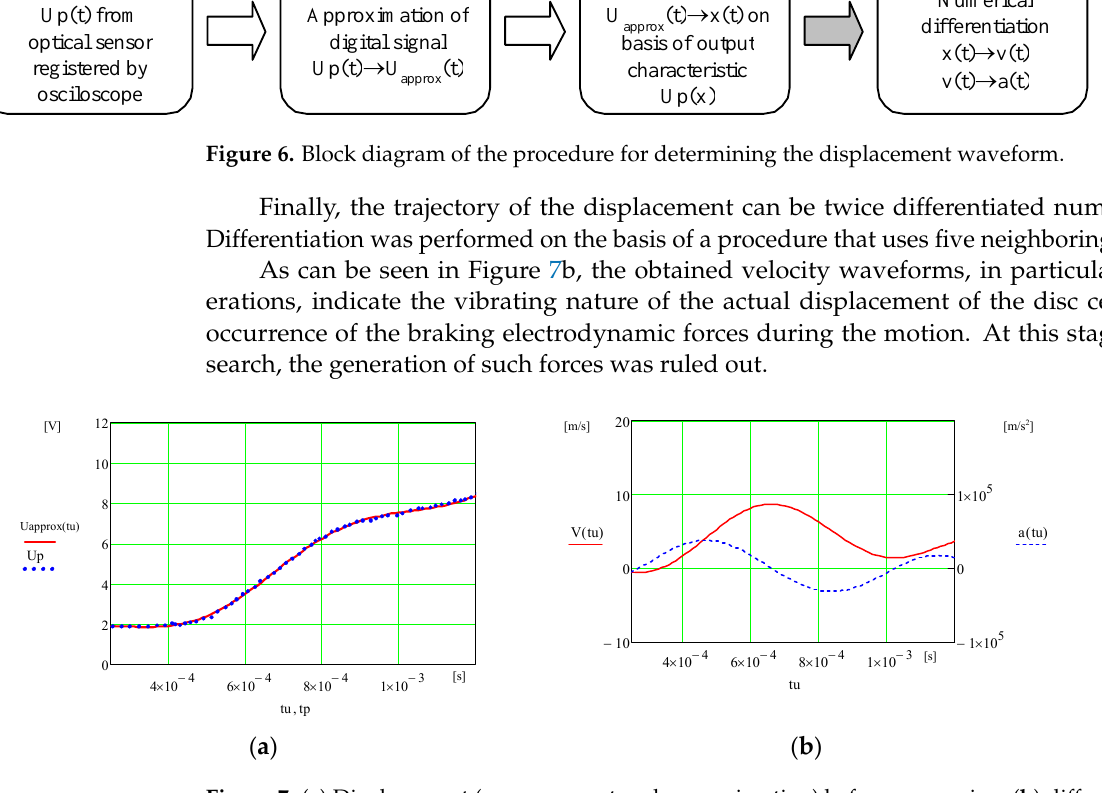
Figure 7. ( a ) Displacement (measurement and approximation) before conversion; ( b ) differentiation of post ‐ conversion displacement.